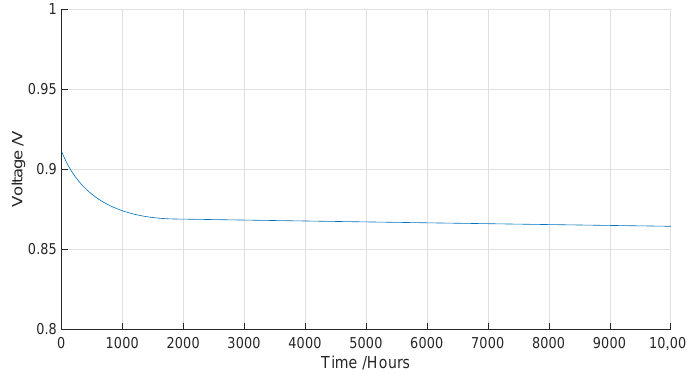
Figure 8. Cell voltage over time at